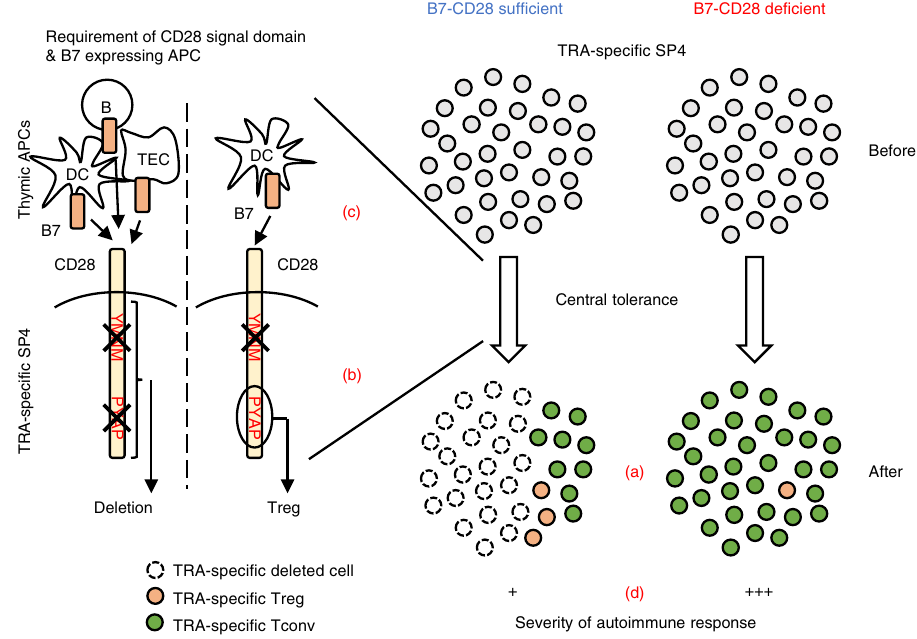
Fig. 7 B7-CD28 co-stimulation mediates thymic clonal deletion and Treg generation through distinct mechanisms to enforce central tolerance and mitigate autoimmunity. a B7-CD28 co-stimulation plays a critical role for clonal deletion of TRA-speci fi c thymocytes as well as for TRA-speci fi c Treg cell generation, two opposite cell fates (cell death vs. cell survival) of strongly TCR-signaled thymocytes. b Although B7-CD28 is required for both clonal deletion and diversion to the Treg lineage, the CD28 signaling domain requirements are distinct for these two cell fates. c Thymic APC (TEC, DC, B cell) requirements also differ for B7-CD28-dependent clonal deletion and Treg cell generation of thymocytes with a given TRA speci fi city, indicating that these two fates are not simple alternative outcomes of the same thymocyte-APC interaction. Illustrated here are the APC requirement for MOG-speci fi c SP4 tolerance through clonal deletion and Treg cell generation. d The consequence of a defect in B7-CD28-dependent thymic clonal deletion is accumulation of peripheral TRA-speci fi c T cells capable of mediating destructive autoimmune response, providing new insight into the role of B7-CD28 co-stimulation in the prevention of